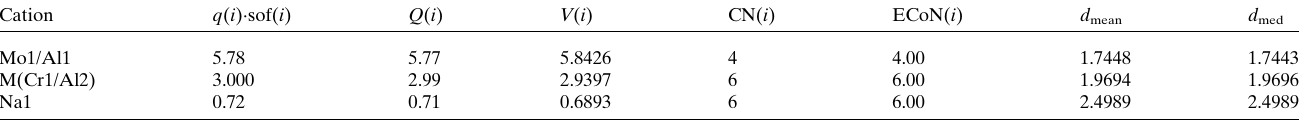
Table 2 CHARDI and BVS analyses for the cations in the Na 0.72 Cr 0.48 Al 1.76 Mo 2.77 O 12 compound.